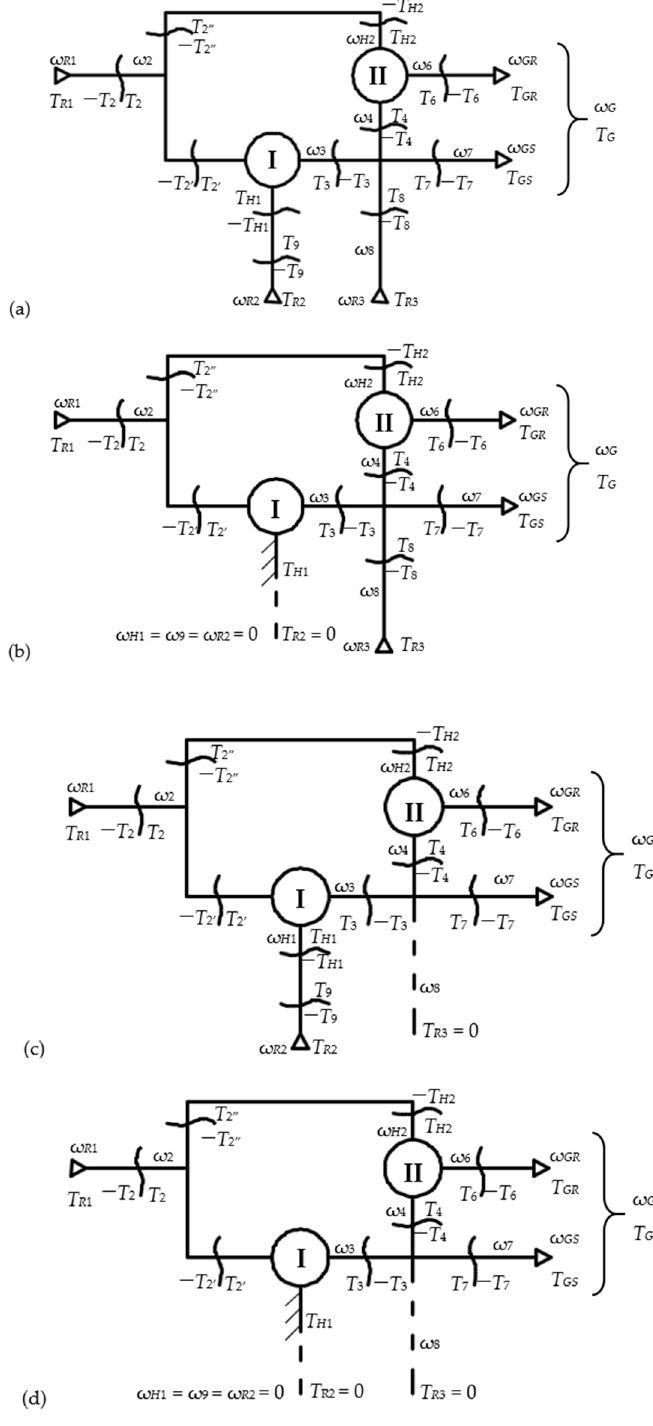
Figure 2. Block diagrams of the transmissions from Figure 1: ( a ) Case A (Figure 1a); ( b ) Case B (Figure 1b); ( c ) Case C (Figure 1c); ( d ) Case D (Figure 1d).